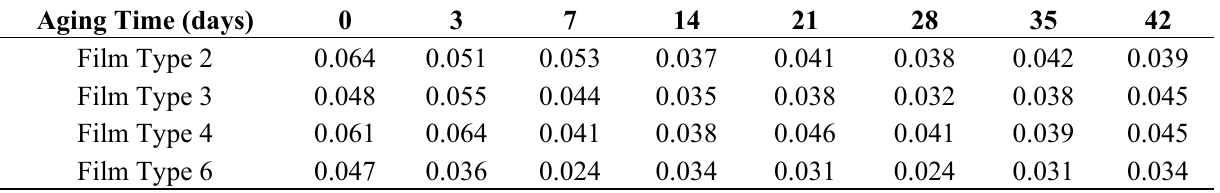
Table A3. Fracture strain vs. aging time at a 100 °C aging temperature for film Types 1–4, which have the same film thickness (5 mil), but various layer